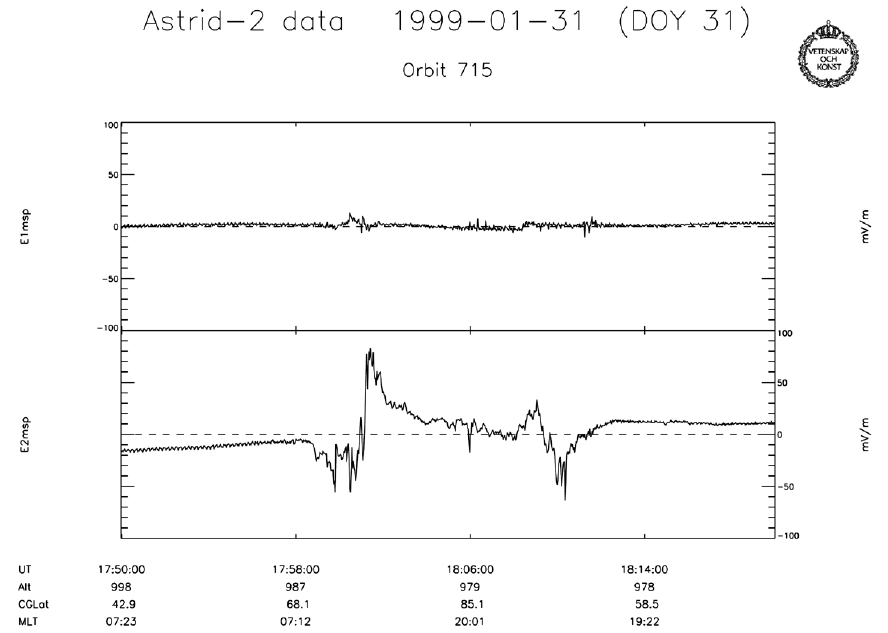
Fig. 5. Electric field data from a Northern Hemisphere polar pass showing the normal two-cell convection pattern with a dawn-to-dusk directed polar cap electric field.